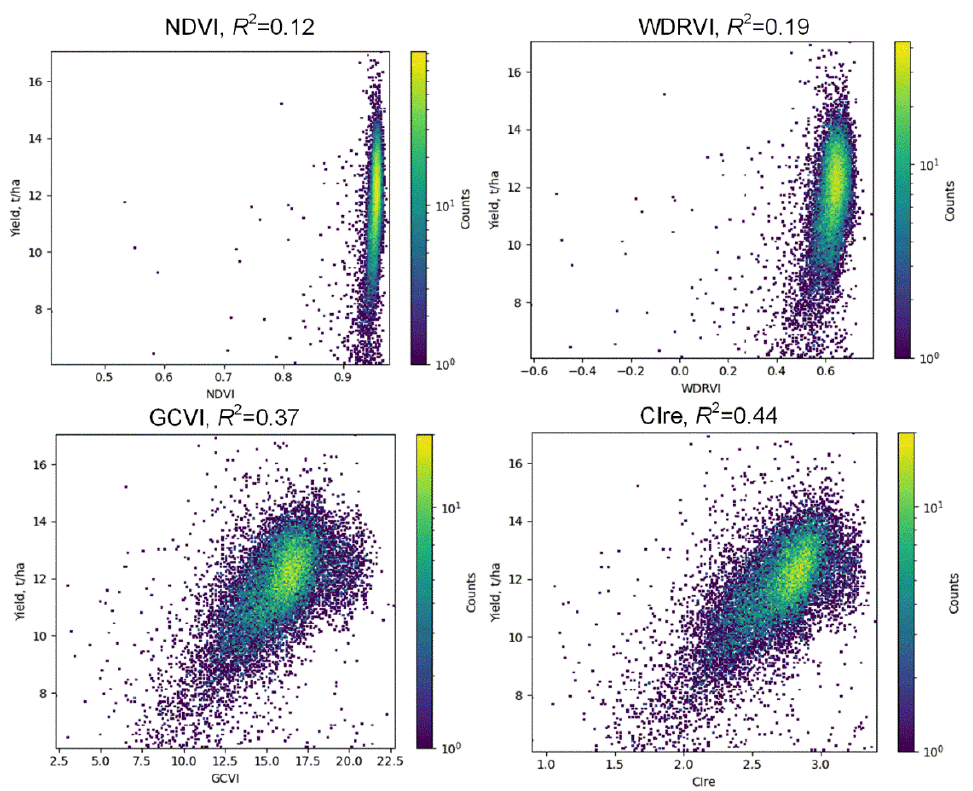
Figure 7. Dependencies between corn yields and NDVI, WDRVI, GCVI, and CIre as derived from the WV-3 imagery acquired on 21 July 2018, 66 days after the planting date. Number of samples is 17,802.